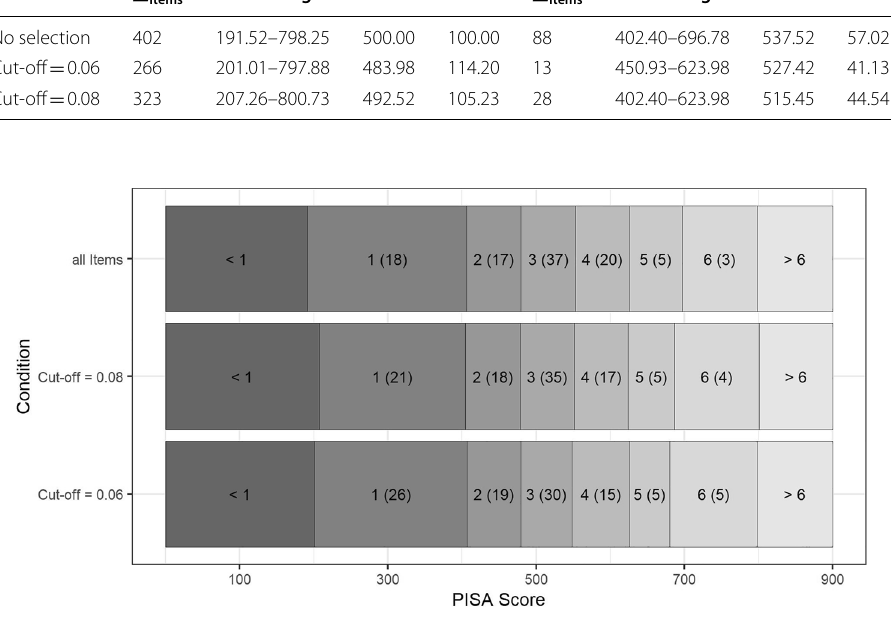
Fig. 2 Proficiency levels and the percentage of items (in parentheses) before and after item selection using the two cut‑off criteria RMSD > 0.08 and RMSD >